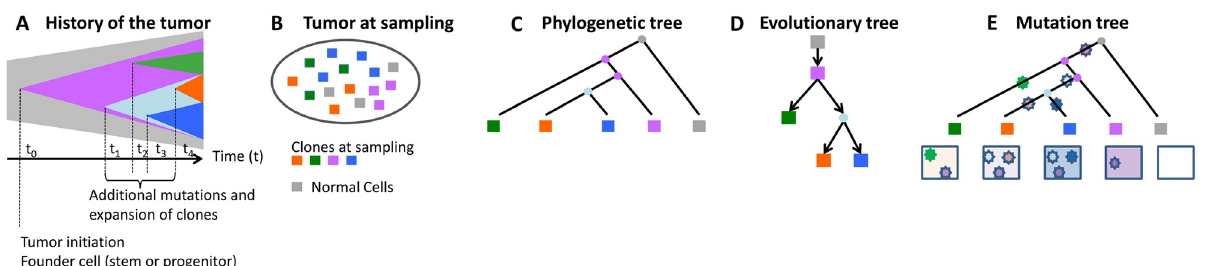
Fig 1. Pictorial representation of tumor evolution. (A—B) A pictorial representation of the evolution of a tumor from the initiating mutation to the heterogeneous tissue at the time of sampling, which consists of four different clones and normal tissue. (C) A phylogenetic tree with single cells as the tips. (D) A clonal lineage tree inferred from sampled cells where each node represents a subclone (cluster of cells). (E) A mutation tree inferred from sampled cells where each star represents the occurrence of one mutation. The box underneath each tip shows which mutations are present in the cell represented by the